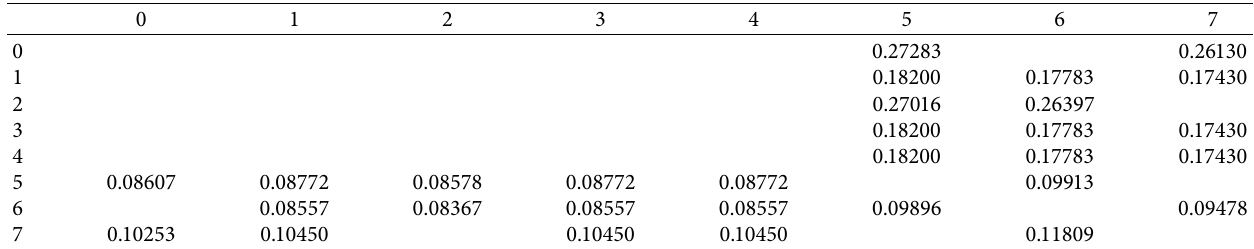
Table 9: Spread probability of each infected node at timeslot 2.